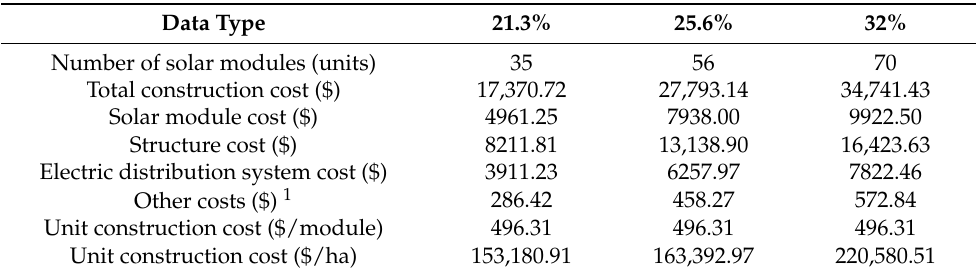
Table 1. Construction costs of the APV system (edited from Kim et al.